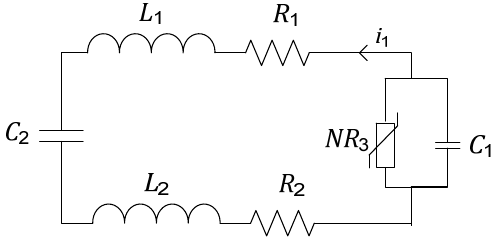
Figure 2. Equivalent model of autonomous EDM process.